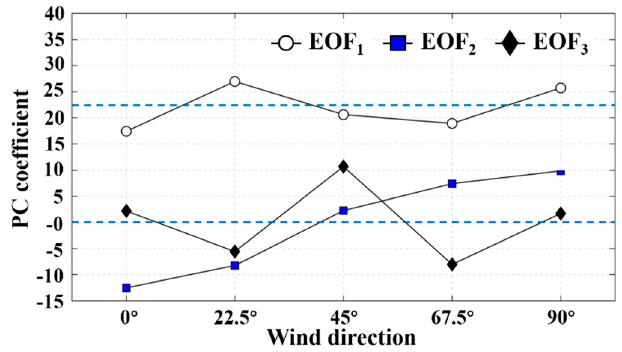
Figure 14. Wind direction coefficients for EOF 1 , EOF 2 , and EOF 3 .